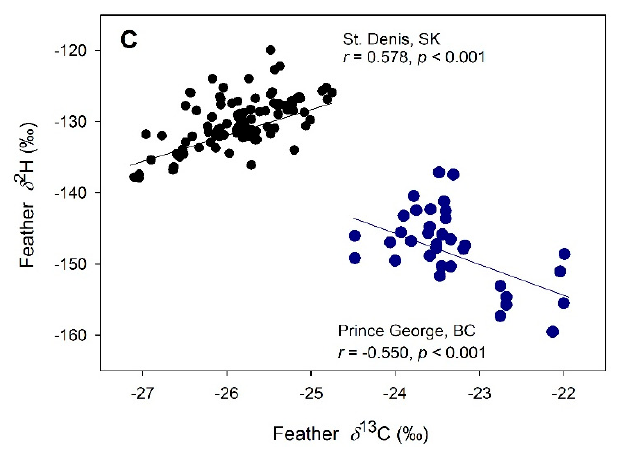
Figure 2. Feather isotope values (‰) for nestling tree swallows from St. Denis, SK (black circles) and Prince George, BC (blue circles), 2008. Pearson correlations (r) are given for relationships between δ 13 C and δ 15 N ( A ), δ 2 H and δ 15 N ( B ), and δ 2 H and δ 13 C ( C ); regression lines are shown for illustration.